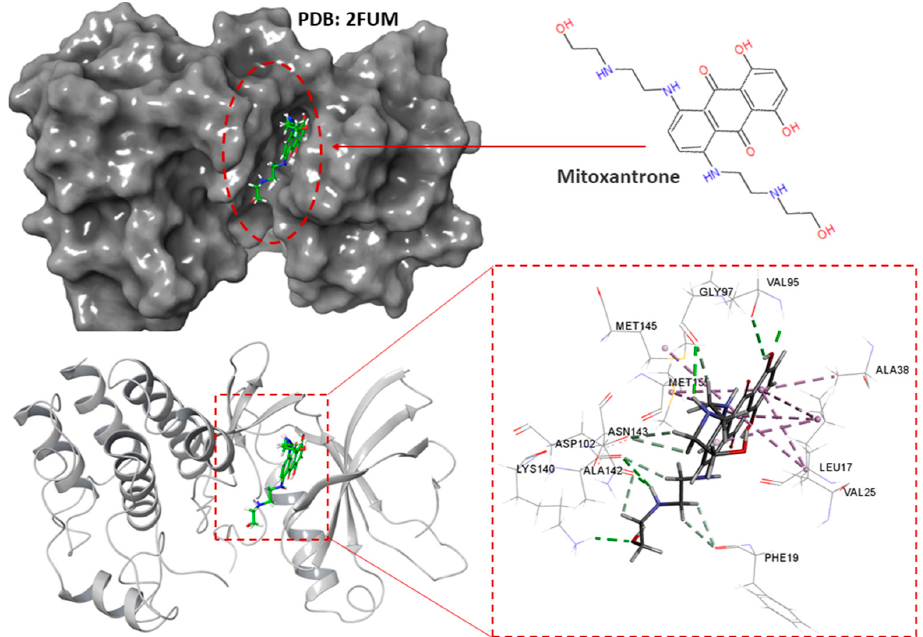
Figure 9. Surface view ( up ) and 3D structure view ( down ) of the co-crystalized mitoxantrone in the active site of PknB